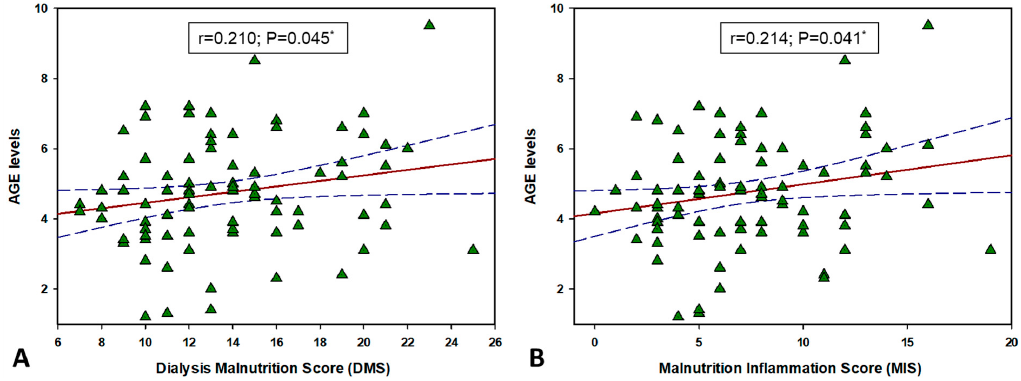
Figure 6. Correlation between AGE levels and Dialysis Malnutrition Score ( A ) and Malnutrition-Inflammation Score ( B ) in HD patients (N = 91). Abbreviations: AGE, advanced glycation end product. *, solid red line represents Pearson’s correlation coefficient, while blue lines represent 95% confidence intervals.